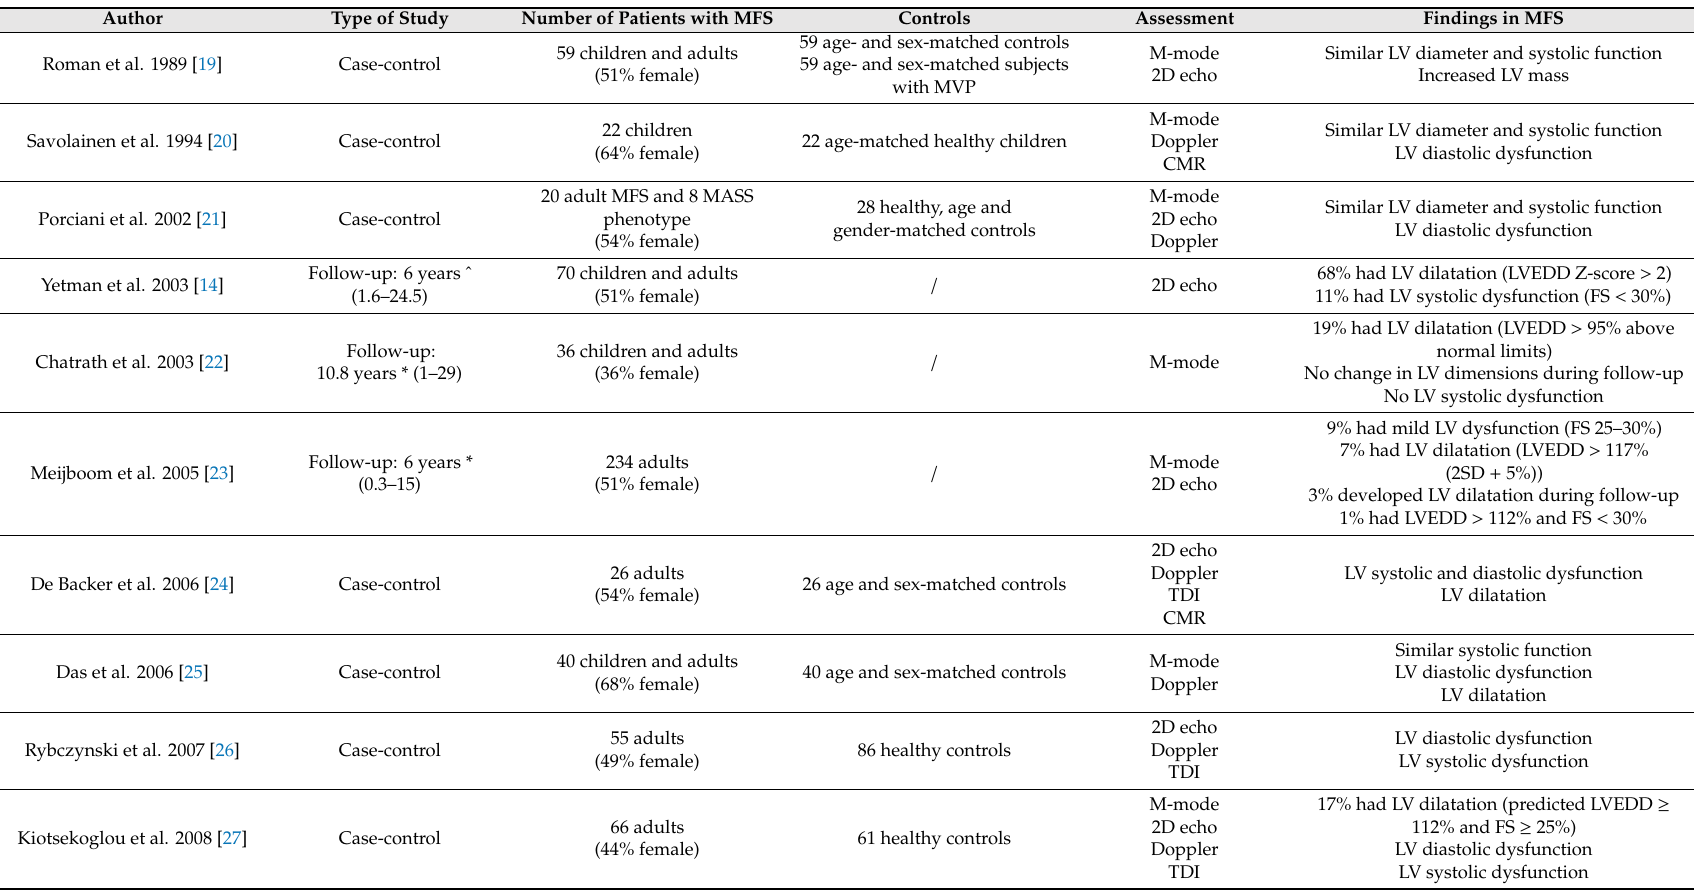
Table 2. Summary of studies assessing myocardial function in